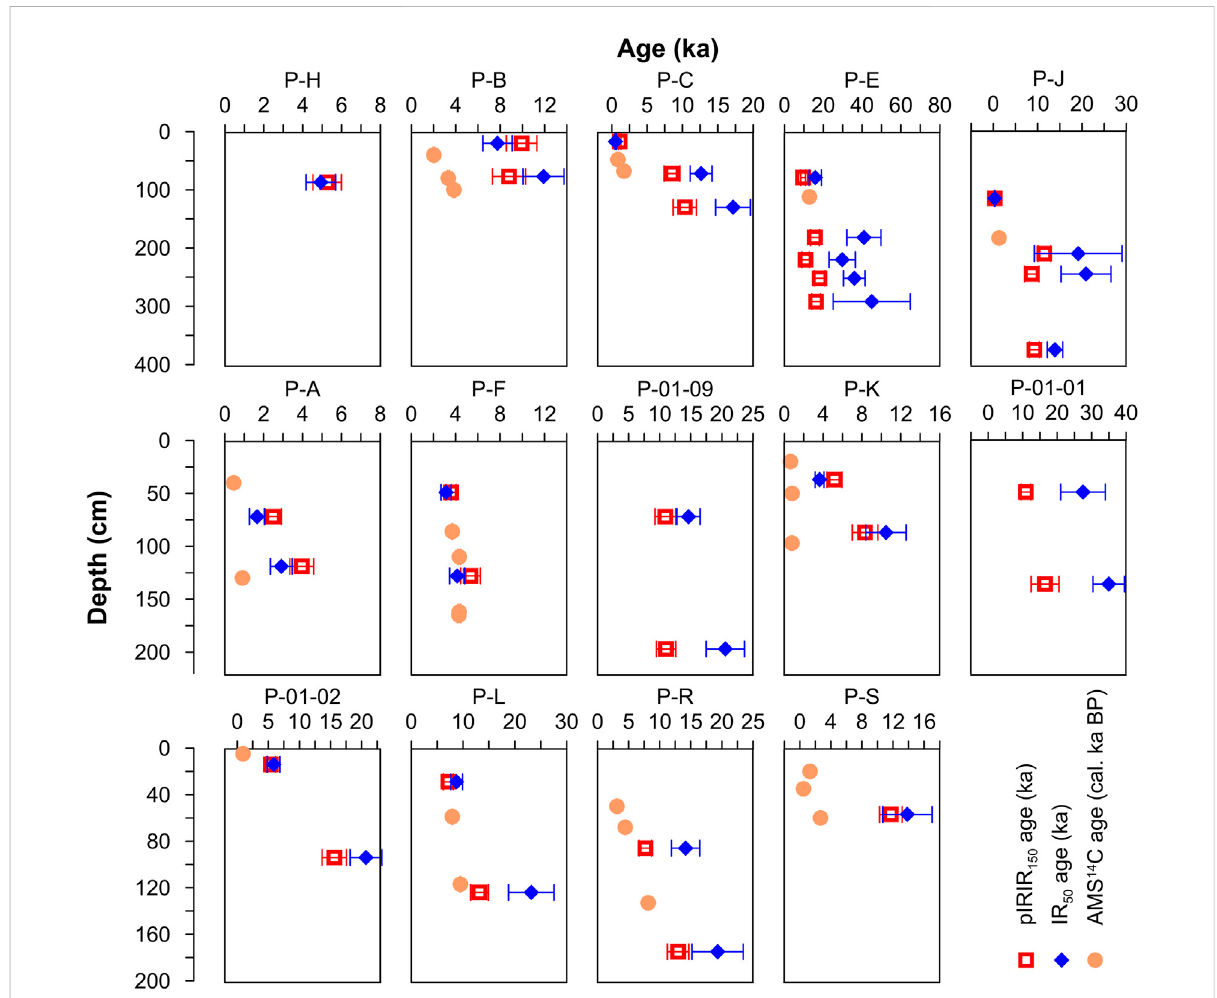
FIGURE 9 Comparison between the luminescence ages and the radiocarbon dates for each pro fi le. The fading corrected pIRIR 150 and IR 50 ages were determined using the sDRC fi tted by a single saturating exponential function and fading corrected following Lamothe et al.